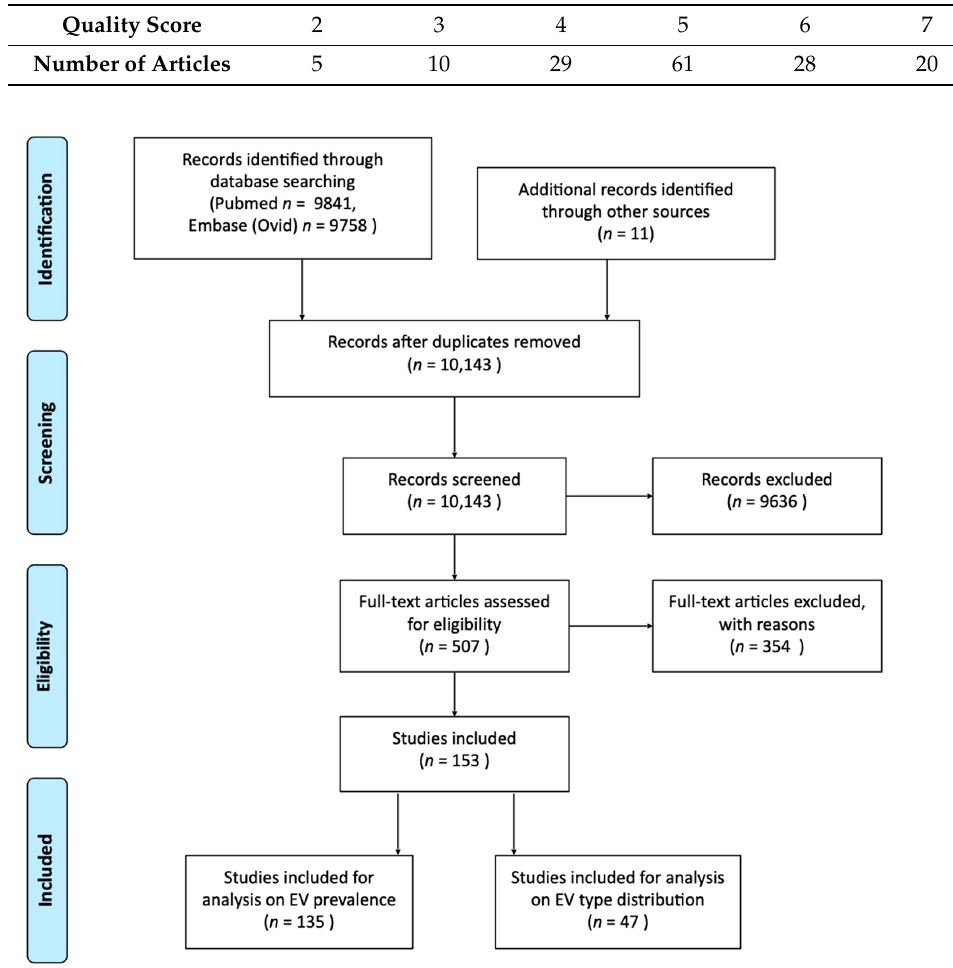
Figure 1. Flow diagram displaying the number of studies identified, screened assessed for eligibil- ity and included [17]. Table 3. Frequency of quality scores for all 153 included papers. Quality was assessed using qual- ity assessment forms (Tables S1 and